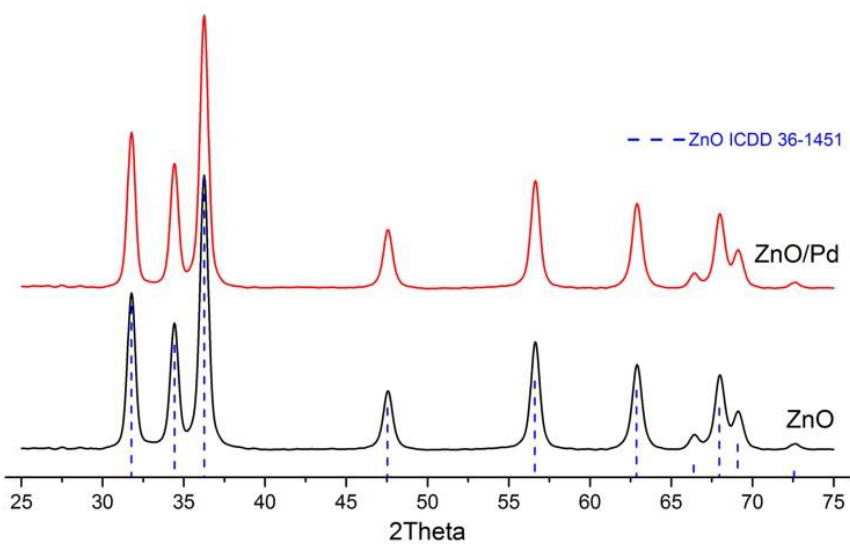
Figure 1. X-ray diffraction patterns of the ZnO and ZnO/Pd nanofibers. Dashed lines correspond to the reflection positions of ZnO (ICDD 36-1451).